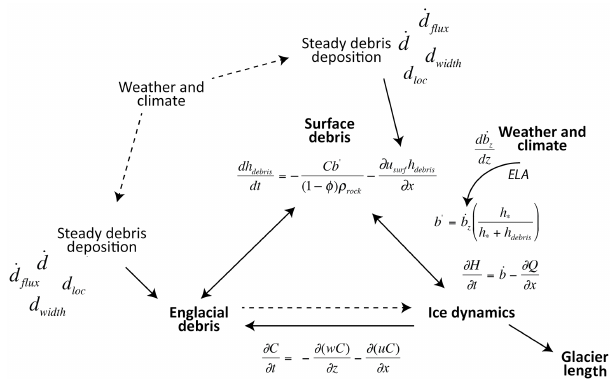
Figure 2. Flow chart of the elements connected in this debris- glacier model. Solid arrows represent the feedbacks we explore. Dashed arrows are